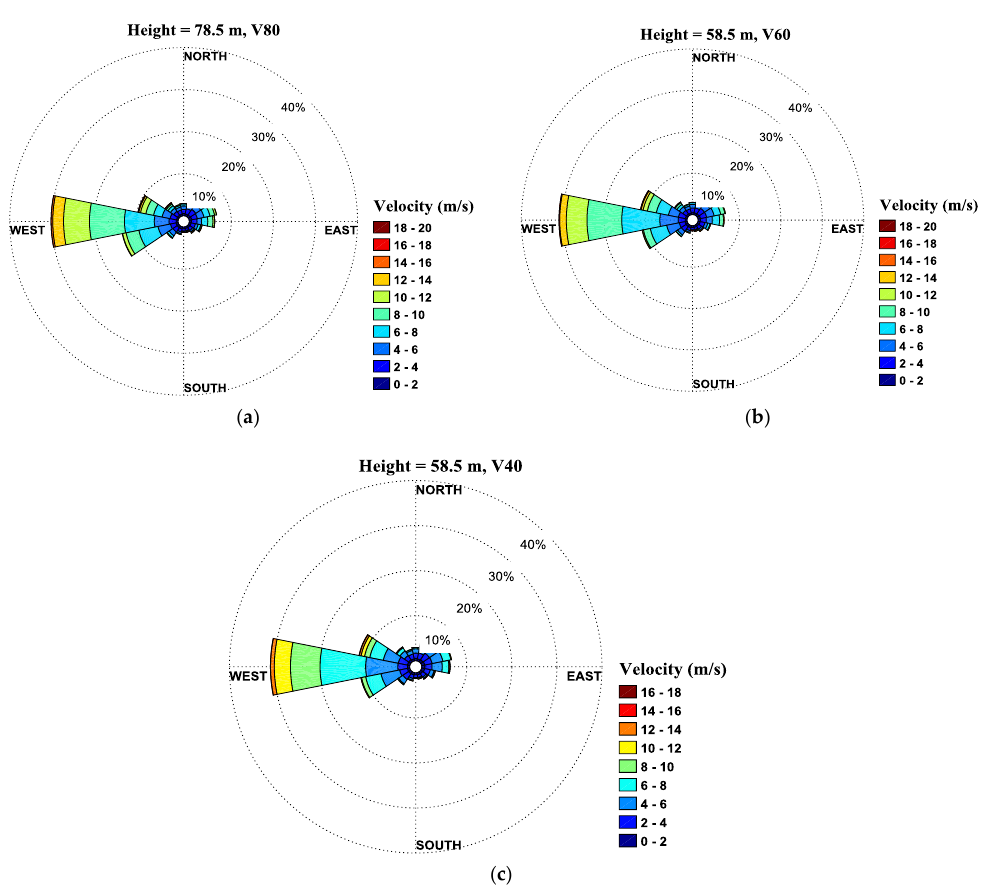
Figure 10. Wind rose for velocities ( a ) 80 m to the direction sensors at 78.5 m height ( b ) 60 m to the direction sensors at 58.5 m height and ( c ) 40 m to the direction sensors at 58.5 m height. The monthly mean wind shear exponent ( ) and shear profile of this site are shown in Figure 11a,b respectively. The wind shear exponent ( ) of the power law model is analyzed for atmospheric boundary layer. It is estimated by using regression analysis using 10 min average data of wind speed sensors at heights of 80 m 60 m, and 40 m for one-year data from Nov-2016 to Oct- 2017. Alpha ( ) keeps on varying with time of the year, and its value is dependent on the site. The overall average of alpha ( ) for Sanghar is 0.229. The minimum wind shear exponent ( ) observed is 0.1528 in the month of June and maximum wind shear exponent ( ) observed is 0.3344 in the month of October.